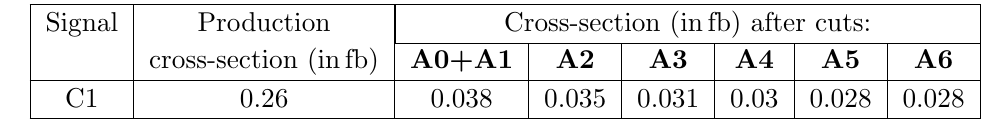
Table 4 . Signal Cross-sections (NLO+NLL) for benchmark C1 for (cid:21) 1 photon + > 2 jets + E= T (cid:12)nal states ( m = 1 e G